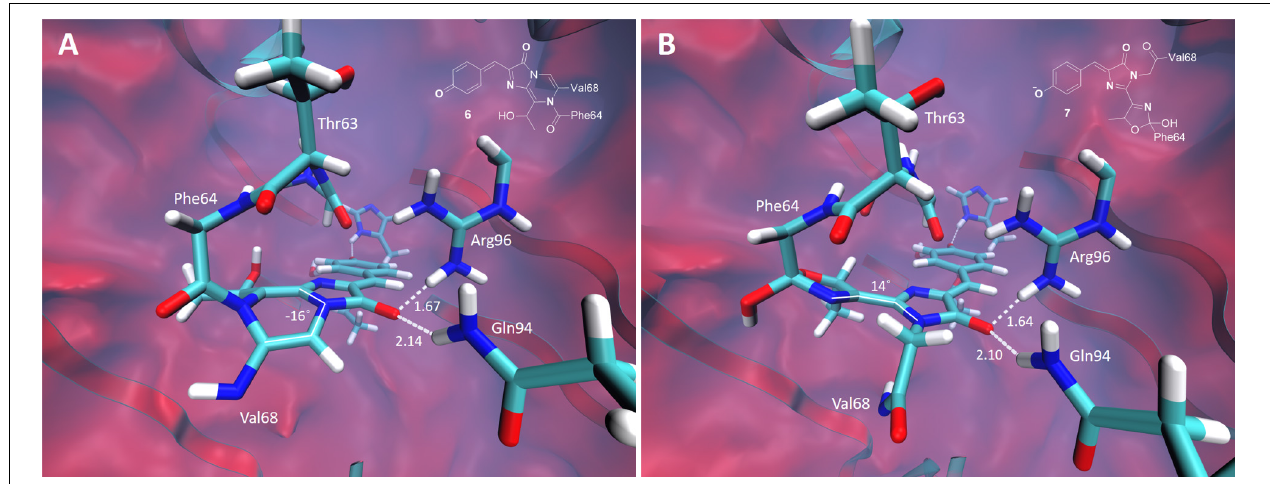
FIGURE 8 | Ground-state equilibrium structures of the cyclic oxidized chromophores. (A) The neutral orange-emitting chromophore. (B) The red-emitting mOrange-like chromophore. Only the QM parts are shown for clarity. All distances are shown in